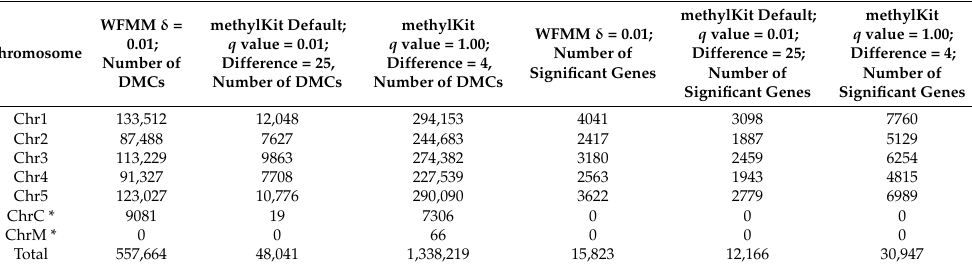
Table 1. The number of significant differentially methylated cytosine (DMCs), and genes recognized by Database for Annotation, Visualization and Integrated Discovery (DAVID) by applying wavelet-based functional mixed model (WFMM) with δ = 0.01 and methylKit with default settings (difference = 25; q value= 0.01) and methylKit with adjusted settings (difference = 4; q value= 1.00) on a real A. thaliana dataset.